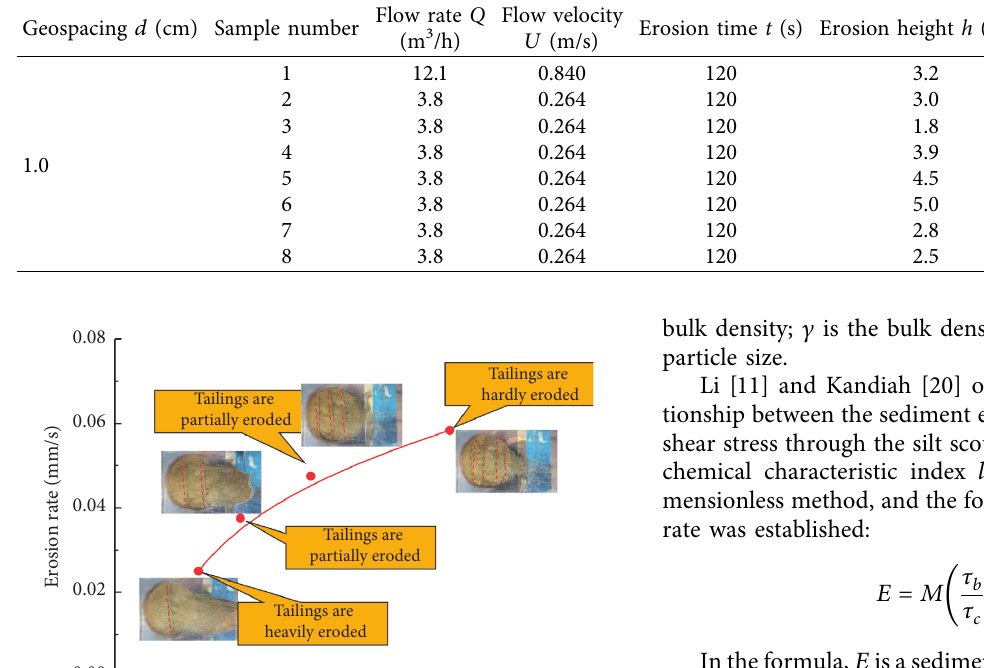
Table 5: Experimental data of tailings erosion with the reinforcement spacing of 1.0cm.